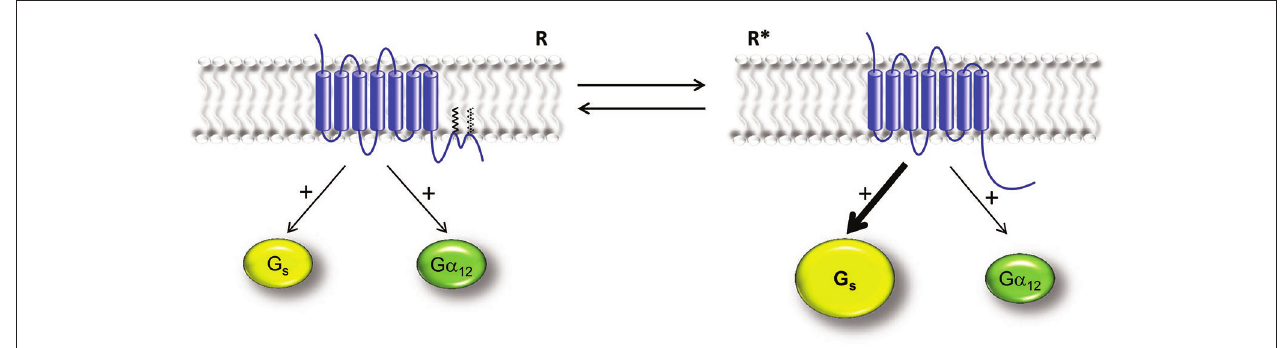
significant increase of the receptor’s capacity to convert from the inactive (R) to the active (R*) form in the absence of an agonists. Palmitoylated receptor shows activation of both G α s - and G α 12 -proteins (left). Non-palmitoylated receptor possesses increased agonist-independent, constitutive activity (R*) towards G α s -mediated signaling, while basal receptor-mediated activation of G α 12 -protein is unaltered